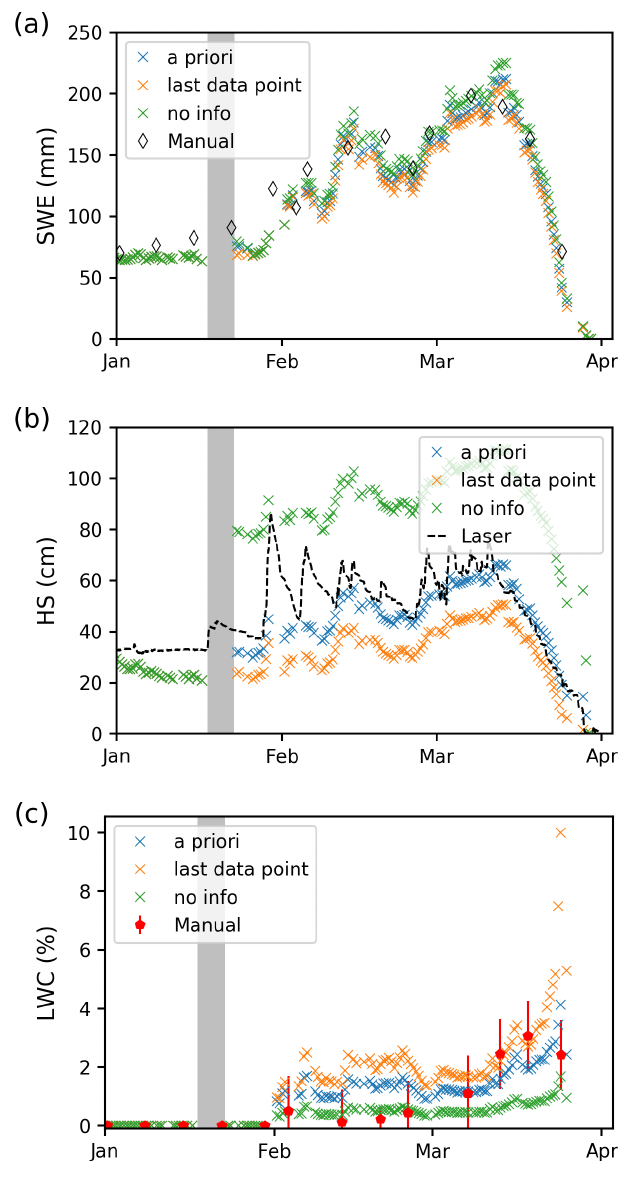
Figure 8. GNSS-derived (a) SWE, (b) HS and (c) LWC after a data gap of 7d with corresponding reference value at the site Klosters for the winter period in 2020. Three approaches were used to derive the snow parameters after the data gap: neglecting any previous infor- mation (green), using the last available HS data point (orange) and using the reference HS measurement as a priori information